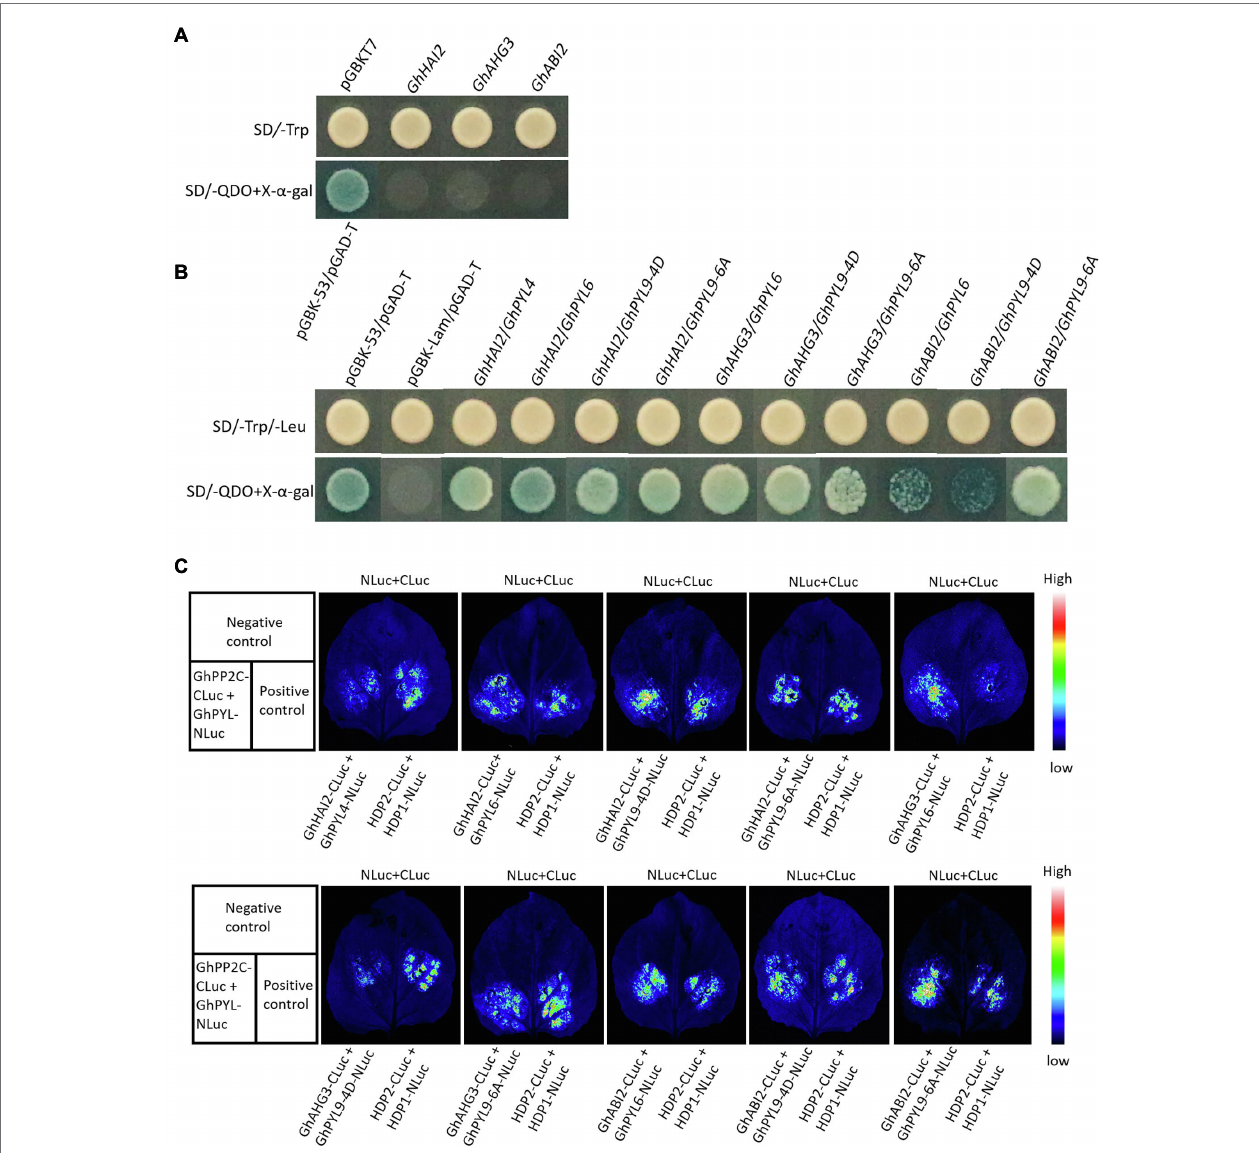
FIGURE 5 | Interaction between GhHAI2, GhAHG3, and GhABI2 and ABA receptors GhPYLs. (A) Determination of self-activation of GhHAI2, GhAHG3, and GhABI2 in the absence of prey. (B) Interaction of GhHAI2, GhAHG3, and GhABI2 and GhPYLs in yeast two-hybrid assay (Y2H). The yeast strain AH109 harboring the construct pairs were plated on synthetic dropout medium either without Trp and Leu (upper panel) or without Trp, Leu, His, and Ade (SD/-QDO) containing X- α - gal (lower panel). The vectors pGBKT7-53/pGADT7-T and pGBKT7-Lam/pGADT7-T were used as positive and negative controls, respectively. (C) Luciferase (LUC) complementation imaging assay for analyzing the protein–protein interaction between GhHAI2, GhAHG3, and GhABI2 and GhPYLs. The specific combinations used for each interaction are indicated. The fluorescence signals represent their interaction